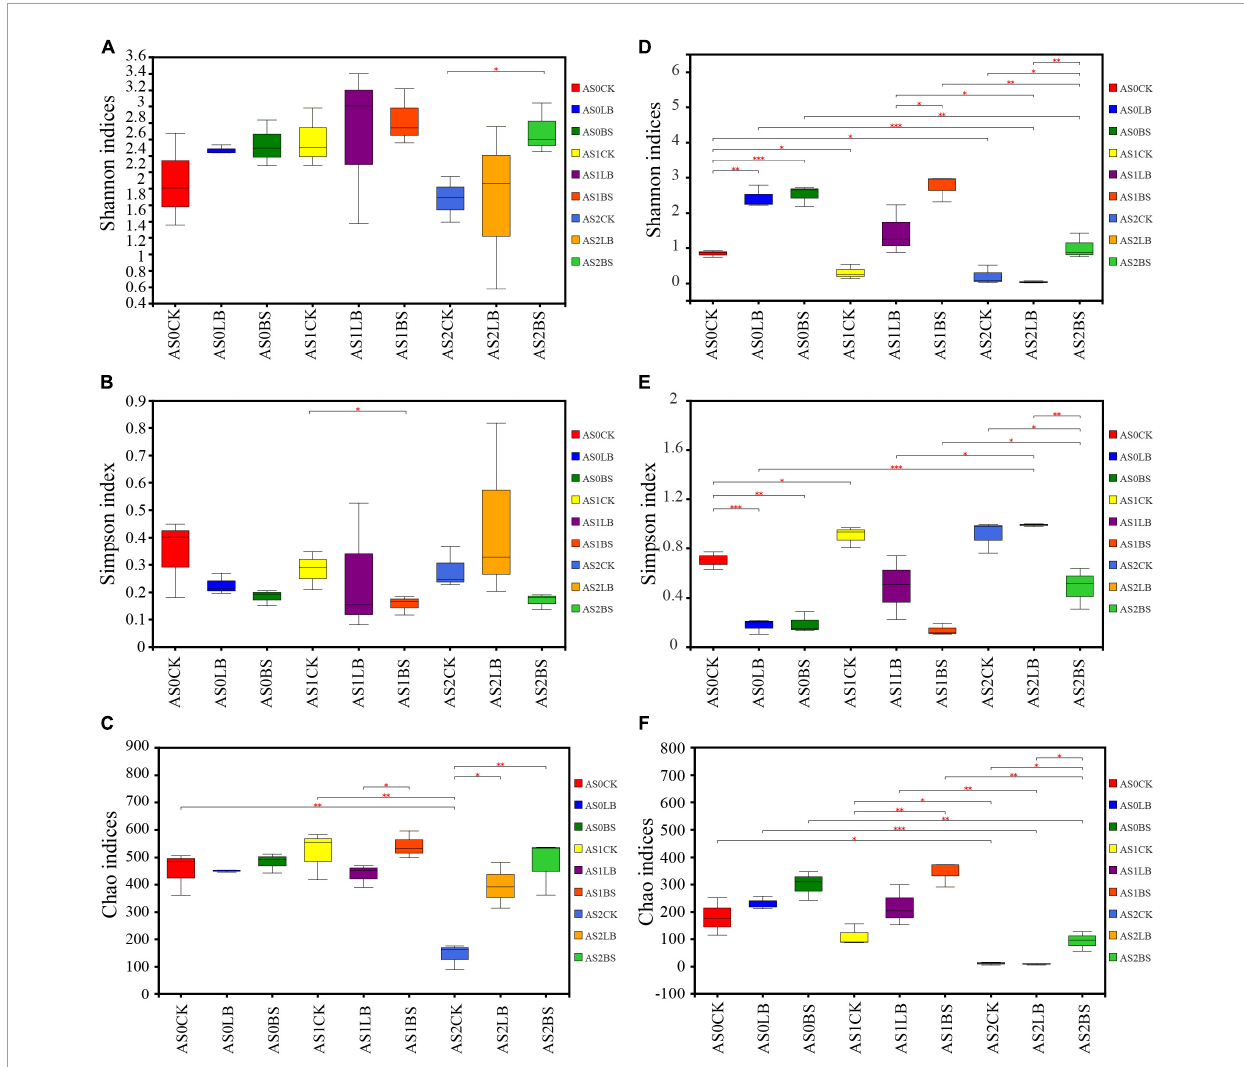
FIGURE3 Differences in bacterial (A–C) and fungal (D–F) community diversity and richness in whole plant corn silage during aerobic exposure. (A) Shannon index. (B) Simpson index. (C) Chao index. (D) Shannon index. (E) Simpson index. (F) Chao index. *Significance at P < 0.05; **significance at P < 0.01; ***significance at P < 0.001. AS0CK, not inoculated silage at 0 h of aerobic exposure; AS0LB, Lentilactobacillus buchneri inoculated silage at 0 h of aerobic exposure; AS0BS, inoculated Bacillus subtilis silage at 0 h of aerobic exposure; AS1CK, not inoculated silage at 18 h of aerobic exposure; AS1LB, Lentilactobacillus buchneri inoculated silage at 18 h of aerobic exposure; AS1BS, inoculated Bacillus subtilis silage at 18 h of aerobic exposure; AS2CK, not inoculated silage at 60 h of aerobic exposure; AS2LB, Lentilactobacillus buchneri inoculated silage at 60 h of aerobic exposure; AS2BS, inoculated Bacillus subtilis silage at 60 h of aerobic